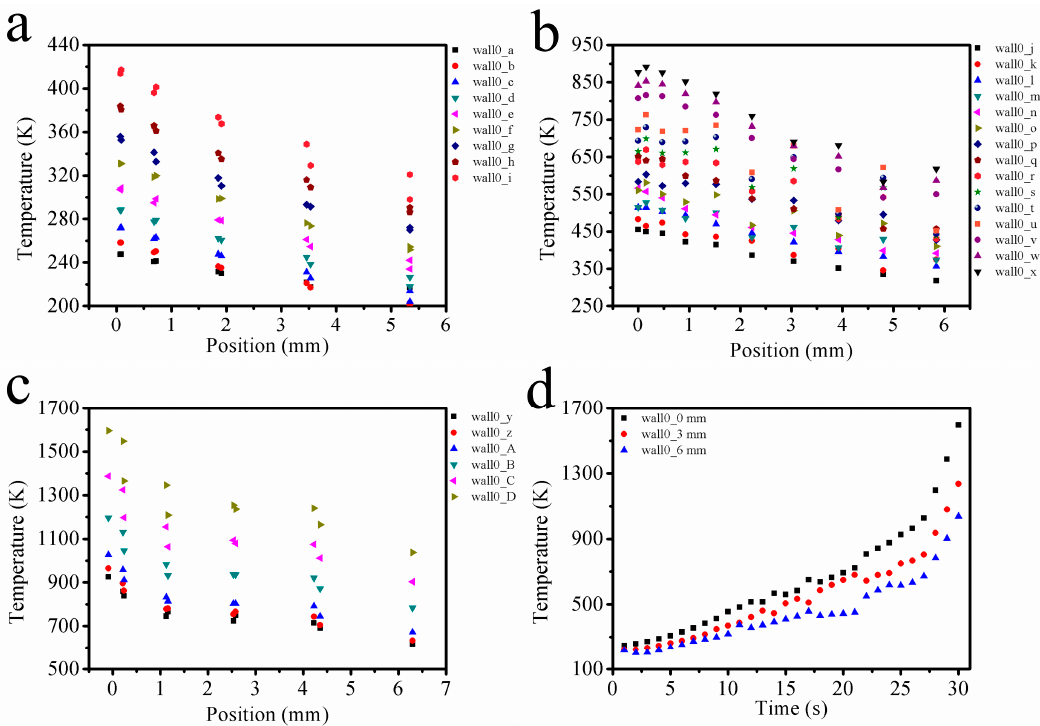
Figure 8. ( a – c ) The scatter graphs of Wall 0 between positions and temperature values and ( d ) the fitting curves.